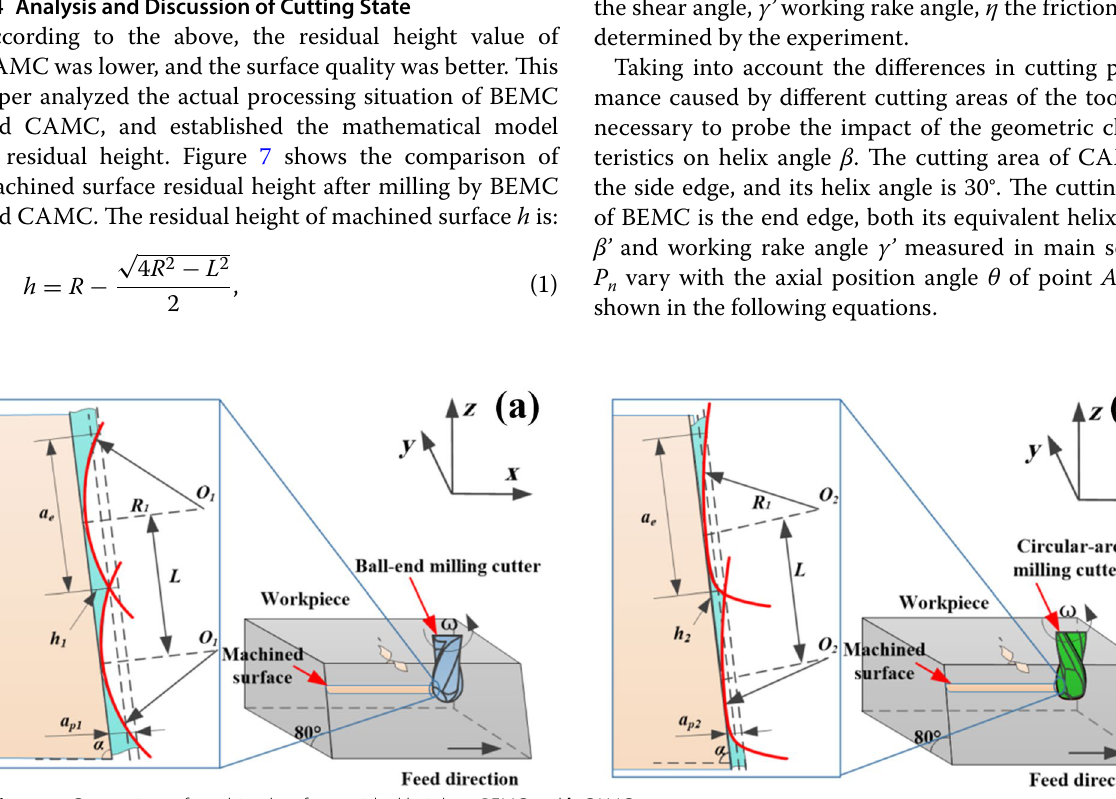
Figure 7 Comparison of machined surface residual height: a BEMC and b